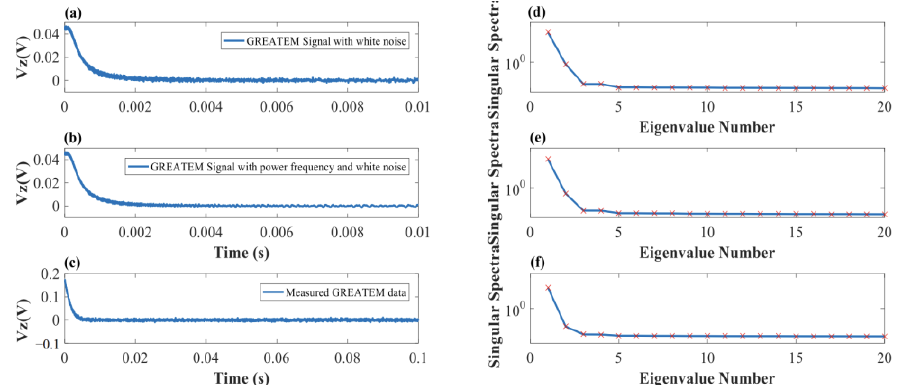
Figure 5. Different GREATEM signals and their singular spectra. ( a ) GREATEM Signal with white noise; ( b ) GREATEM Signal with power frequency and white noise; ( c ) Measured GREATEM data; ( d ) singular spectra of ( a ); ( e ) singular spectra of ( b ); ( f ) singular spectra of ( c ).